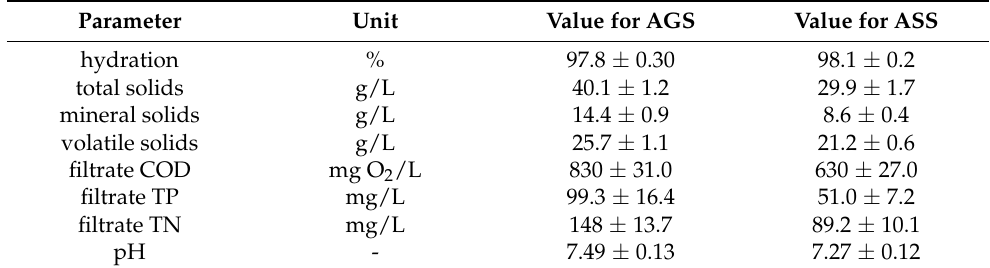
Table 2. Characteristics of anaerobic granular sludge (AGS) and anaerobic suspended sludge (ASS) used for reactor